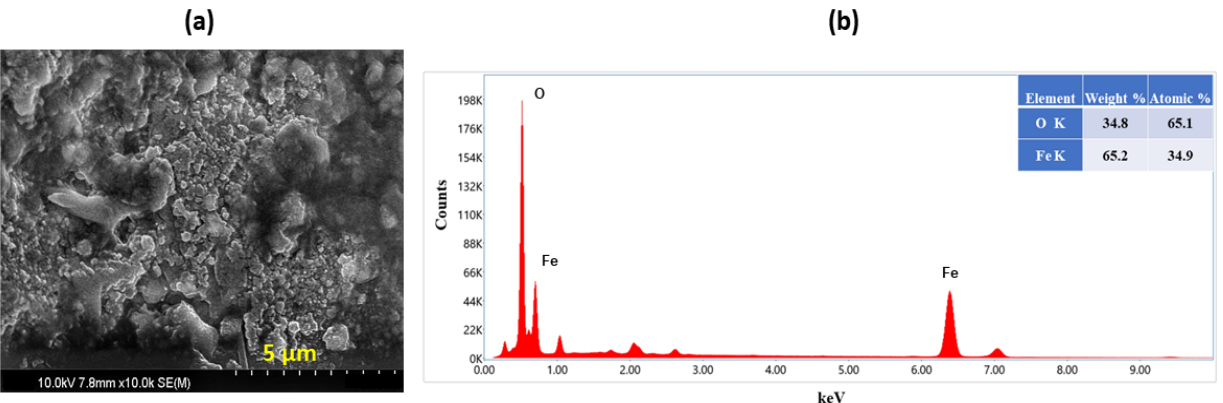
Figure 3. ( a ) FE-SEM images of biosynthesized IONPs at a magnification of 5 µm, ( b ) EDX spectrum of biosynthesized IONPs.